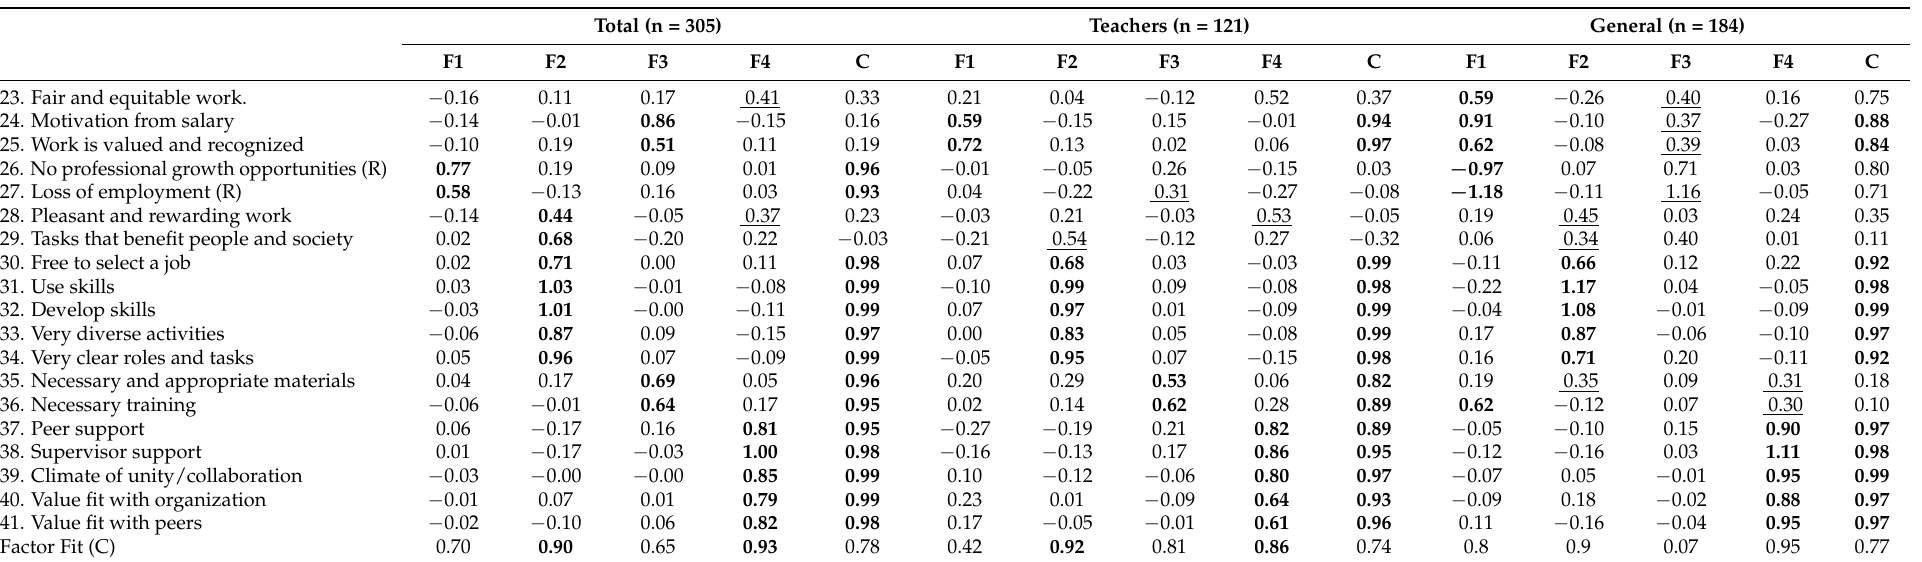
Table 6. Positive psychosocial resource factors: semi confirmatory factor analysis, first